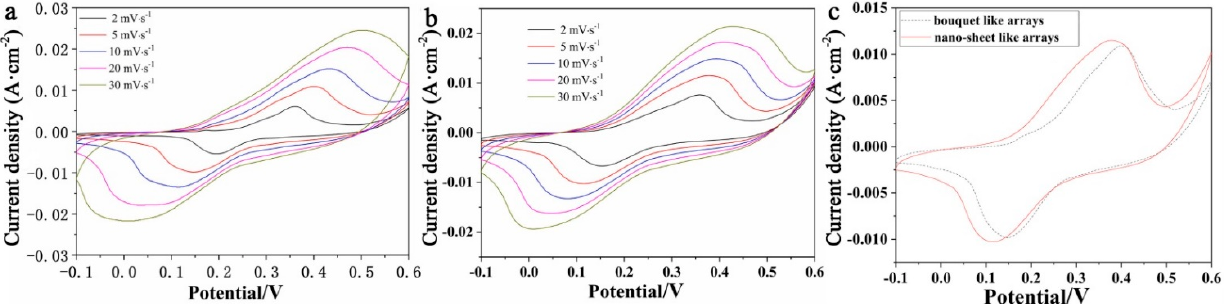
Figure 4. CV curves of ( a ) MHP bouquet arrays/ACF electrode; ( b ) MHP nano-sheet arrays/ACF electrode; ( c ) both elec- trodes at scan rate of 5 mV/s.